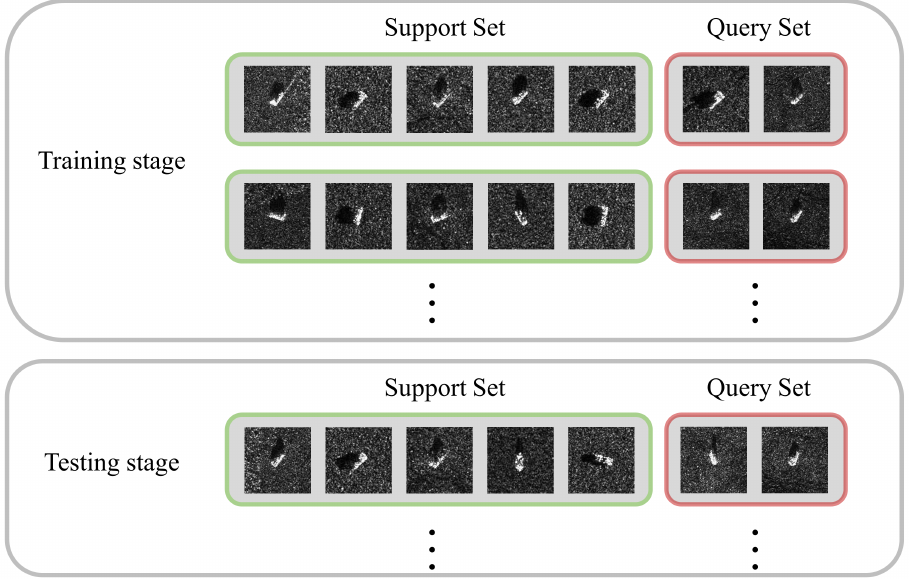
Figure 1. A demonstration of